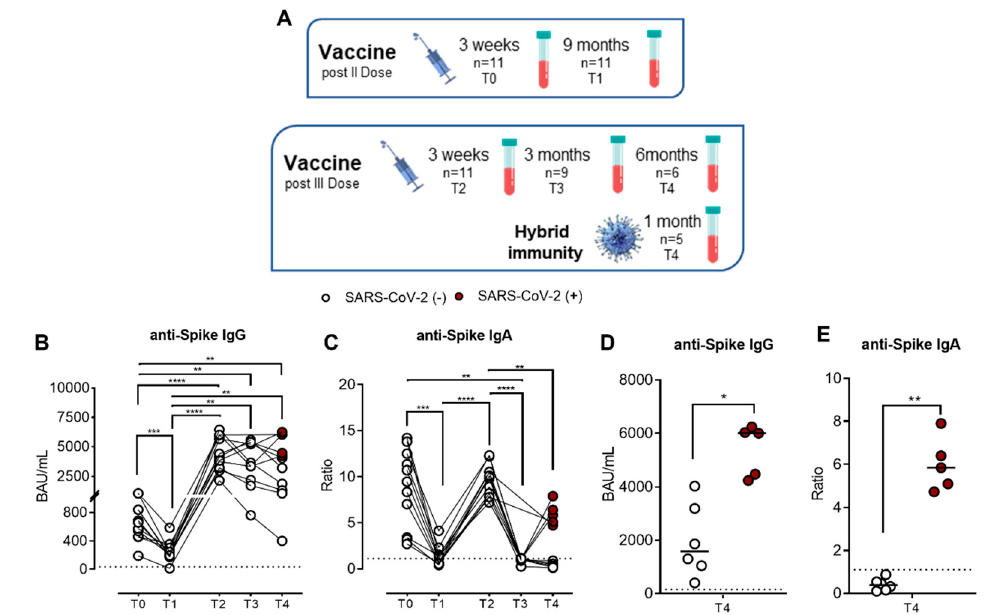
Figure 1. Kinetics of total anti-SARS-CoV-2 IgG and IgA serum antibody levels (n = 11) of the Pfizer-BioNTech BNT162b2 mRNA-based vaccination in immunocompetent (IC), healthy subjects. ( A ) Schematic timing of sampling for the evaluation of the humoral response to the vaccine in our studied cohort. Both serum antibodies were evaluated three weeks (T0) and nine months (T1) after the second dose and three weeks (T2), three months (T3), and six months (T4) after the third booster dose for uninfected subjects or one month after a SARS-CoV-2-negative swab for infected subjects. Vaccinated subjects who contracted SARS-CoV-2 infection during the follow-up (n = 5) are indicated as SARS-CoV-2 (+) (red dots), whereas uninfected subjects (n = 6) are as SARS-CoV-2 ( − ) (white dots). ( B ) Anti-SARS-CoV-2 S1/S2 IgG levels and ( C ) anti-SARS-CoV-2 S1 IgA levels at T0, T1, T2, T3, and T4. ( D ) Comparison of anti-SARS-CoV-2 S1/S2 IgG levels and ( E ) anti-SARS-CoV-2 S1 IgA levels at T4 between vaccinated SARS-CoV-2 (+) and SARS-CoV-2 ( − ) subjects (n = 6). The dotted